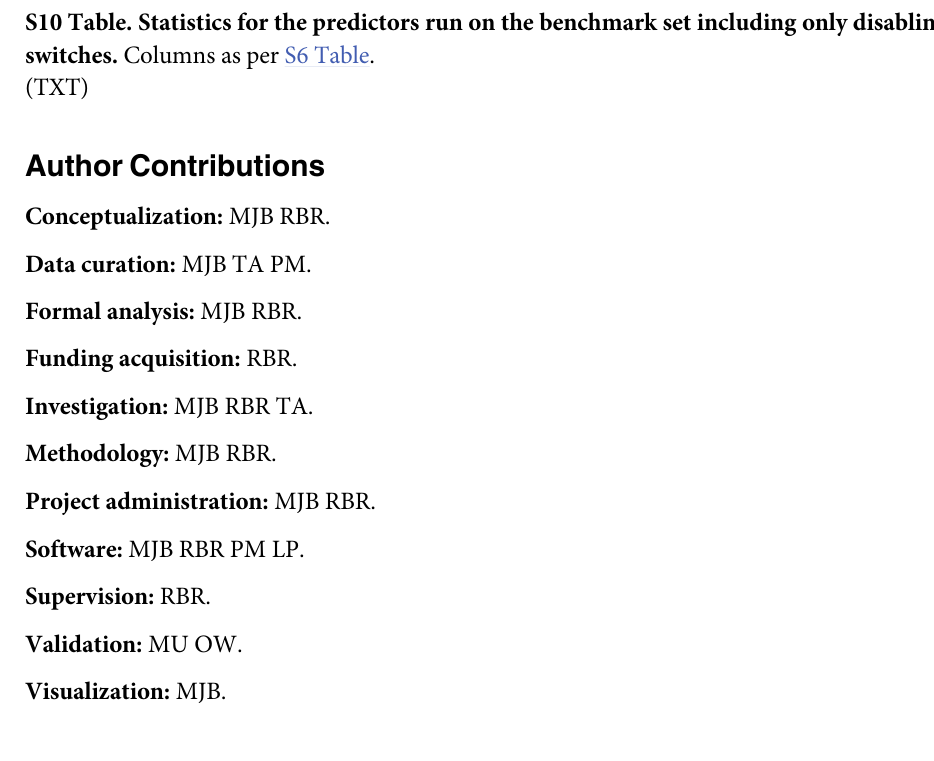
S7 Table. Statistics for the predictors run on the benchmark set with kinase interactors removed. Columns as per S6 Table. S8 Table. Statistics for the predictors run on the benchmark set with fID < 0.99 removed. Columns as per S6 Table. S9 Table. Statistics for the predictors run on the benchmark set including only enabling switches. Columns as per S6Table. S10 Table. Statistics for the predictors run on the benchmark set including only disabling switches. Columns as per S6